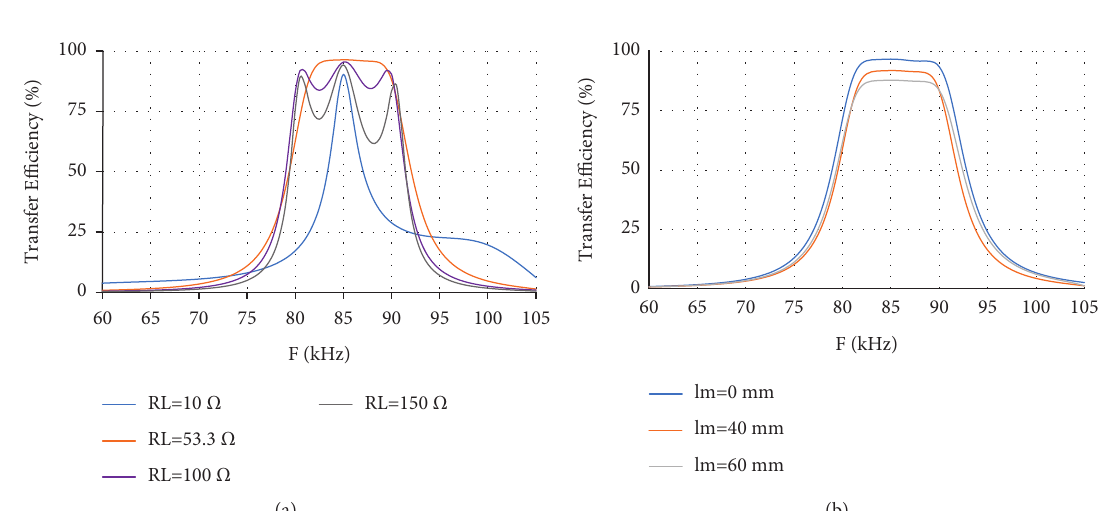
Figure 6: Frequency characteristics of the transfer efficiency. (a) l